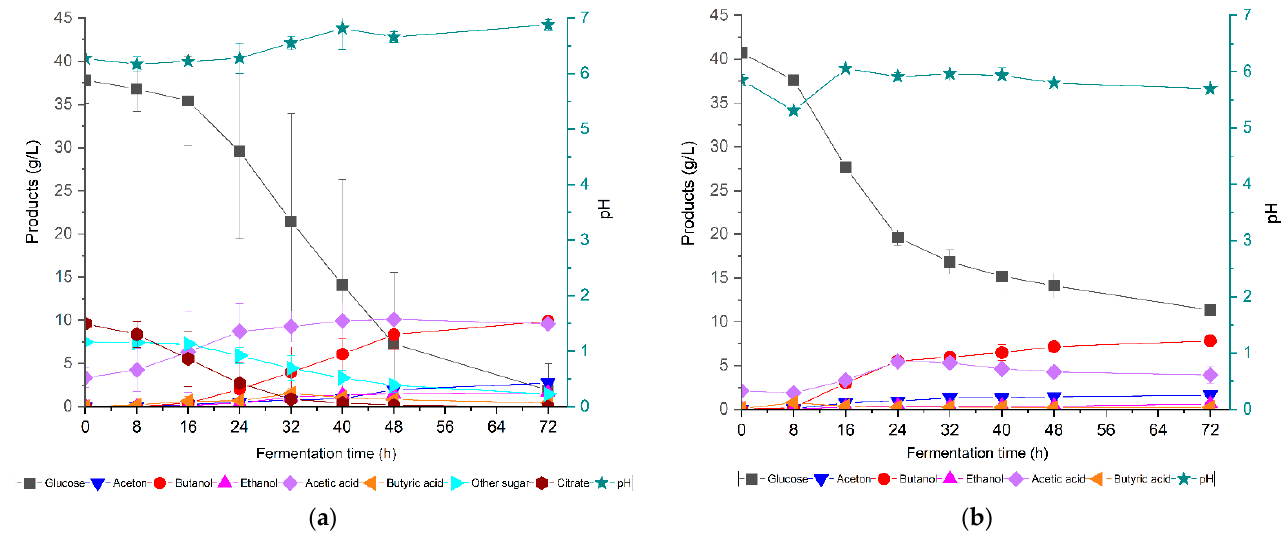
Figure 6. ABE fermentation using C. saccharoperbutylacetonicum DSM 14923 from different carbon sources: ( a ) enzymatic hydrolysates of mixed Enset waste, pretreated with 2% ( w / w ) NaOH; ( b ) control medium with 40 g/L glucose.